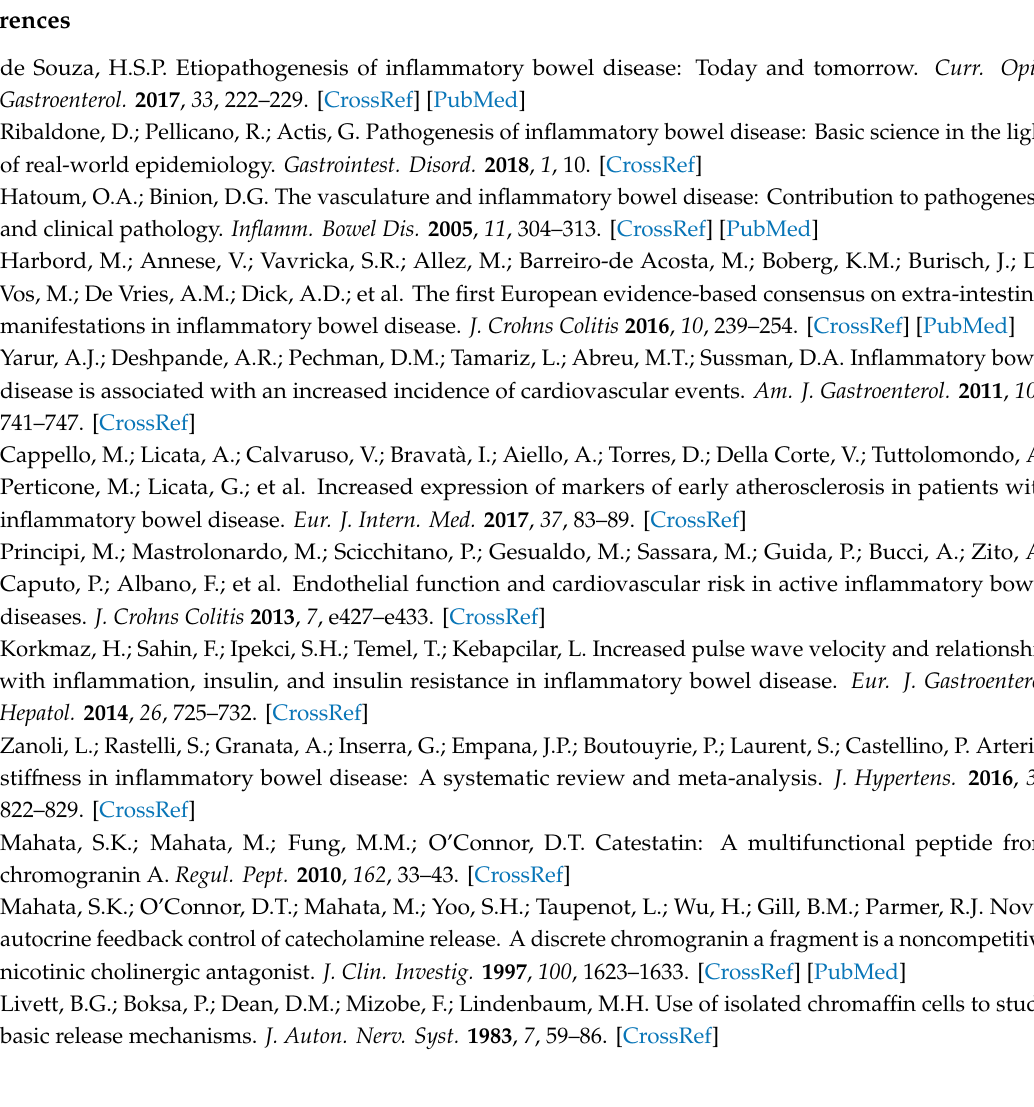
Figure S1: Flow diagram, Table S1: Detailed laboratory characteristics of IBD and control group, Table S2: Detailed laboratory characteristics of UC and CD group, Table S3: Comparison of CST levels between IBD subgroups according to median of disease duration and PWV thresholds for end-organ damage, Table S4: Comparison of CST levels between IBD subgroups according to biologic therapy, Table S5: Prevalence of abnormal age-adjusted PWV valuess among studied groups, Table S6: Comparison of selected arterial sti ff ness parameters between UC and CD